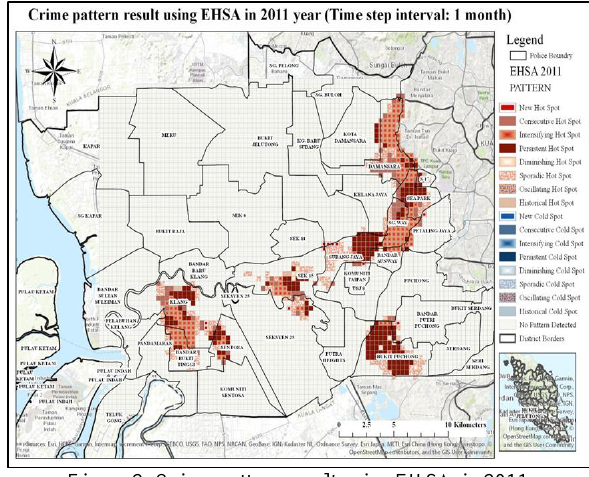
Figure 2: Crime pattern result using EHSA in 2011